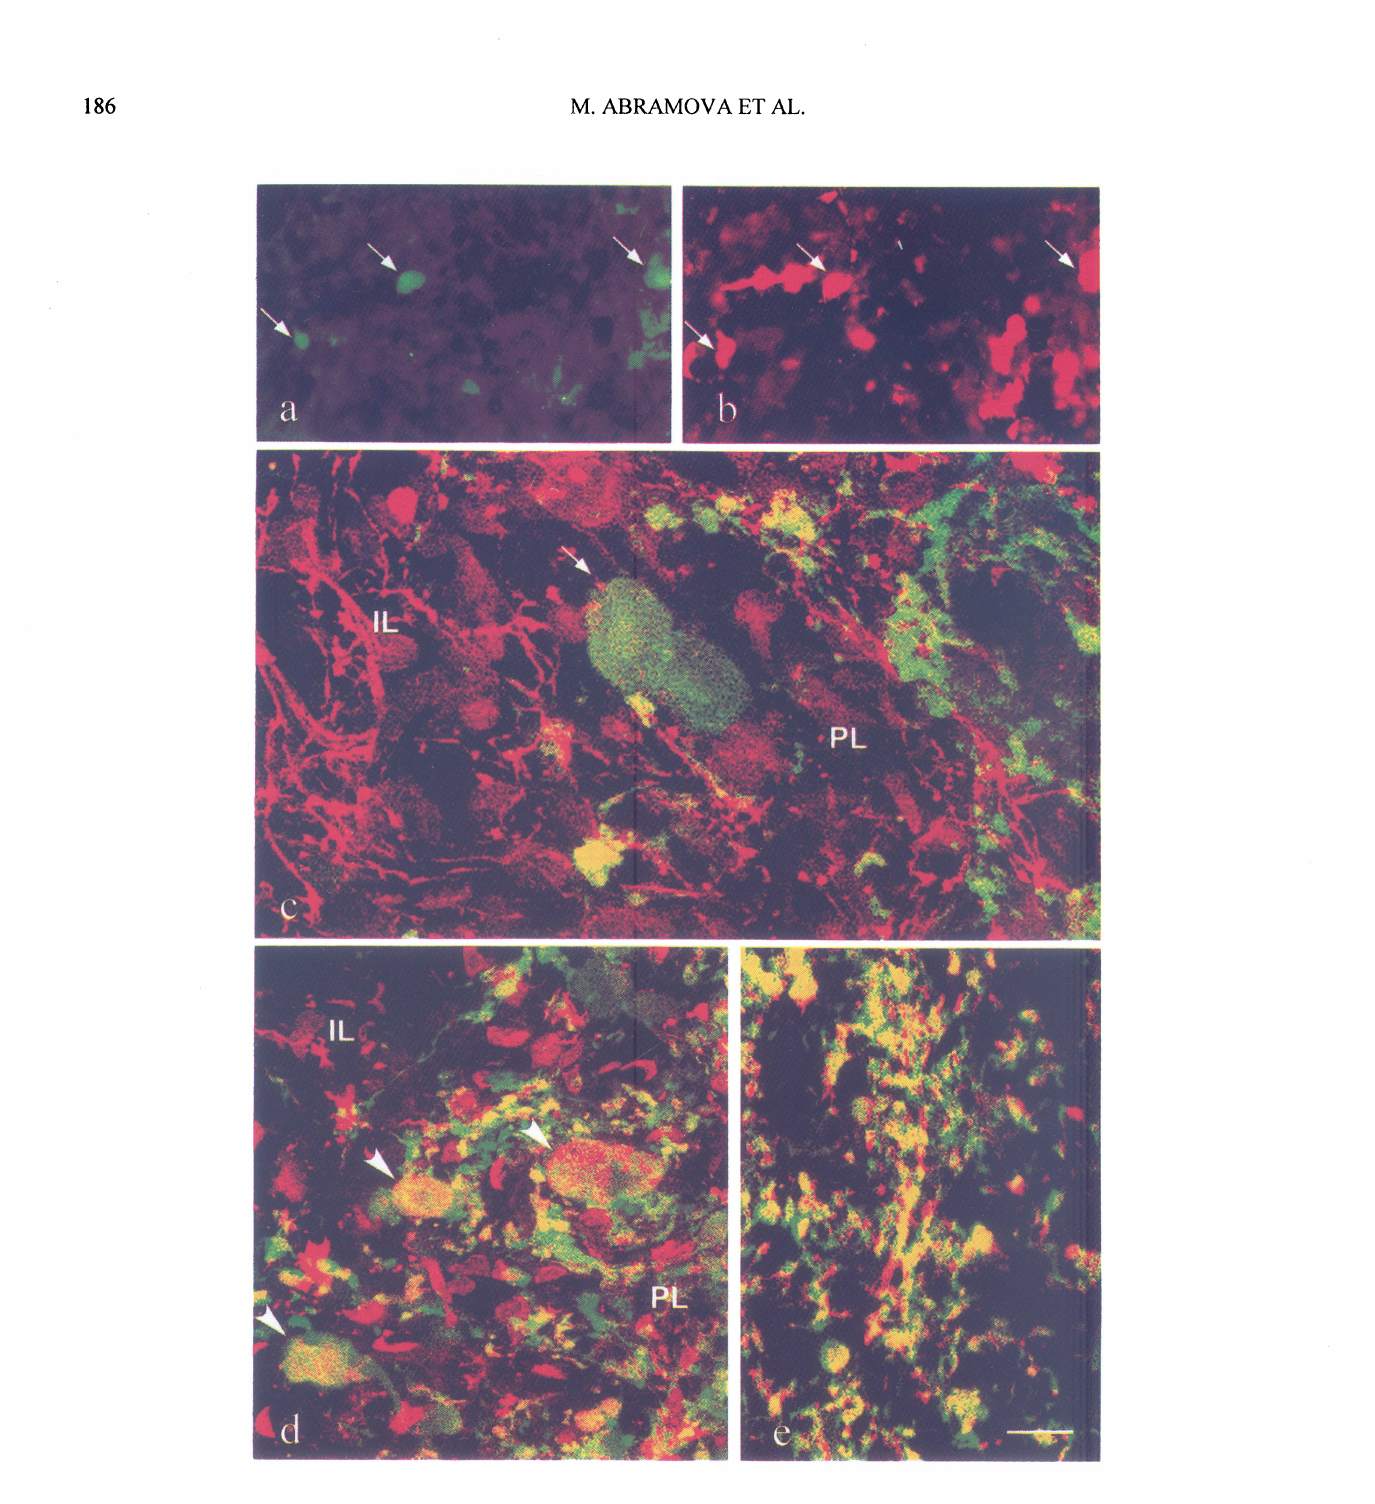
Fig. 6: Herring bodies (a, b, c, d) and small axon swellings (e) immunoreactive for vasopressin (rhodamine, red for b; fluorescein, green for c, d, e), tyrosine hydroxylase (fluorescein, green for a; rhodamine, red for c, d, e) as well as for both vasopressin and tyrosine hydroxylase (yellow for c, d, e) in the posterior lobe (PL) of rats salt-loaded for a week. a, b, fluorescent microscopy; c-e, confocal microscopy. IL, intermediate lobe. Arrows, vasopressin- and/or tyrosine hydroxylase-immunoreactive Herring bodies; arrowheads, double-labeled Herring bodies with zonality in the distribution ofthe immunoreactive material. Scale bar 20 gm for a, b; 6 gm for c and 8 gm for d,